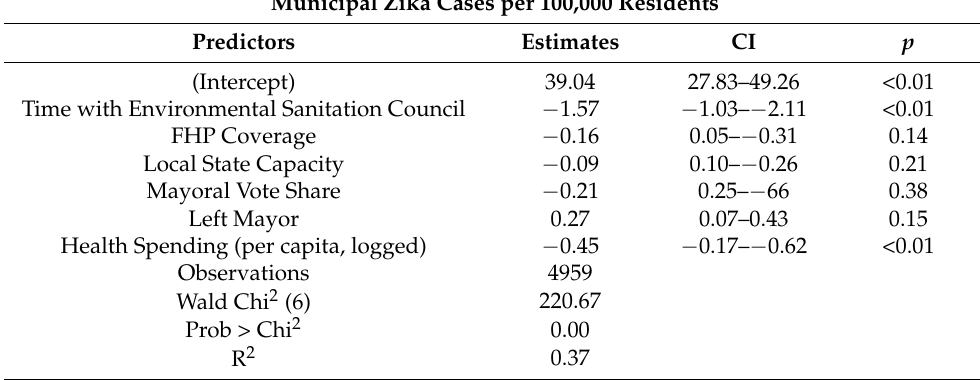
Table 3. Maturity of Environmental Sanitation Policy Councils and Zika, 2016–2017. This table reports the results of negative binomial estimation following pre-processing through Coarsened Exact Matching for each year that municipalities used an environmental sanitation